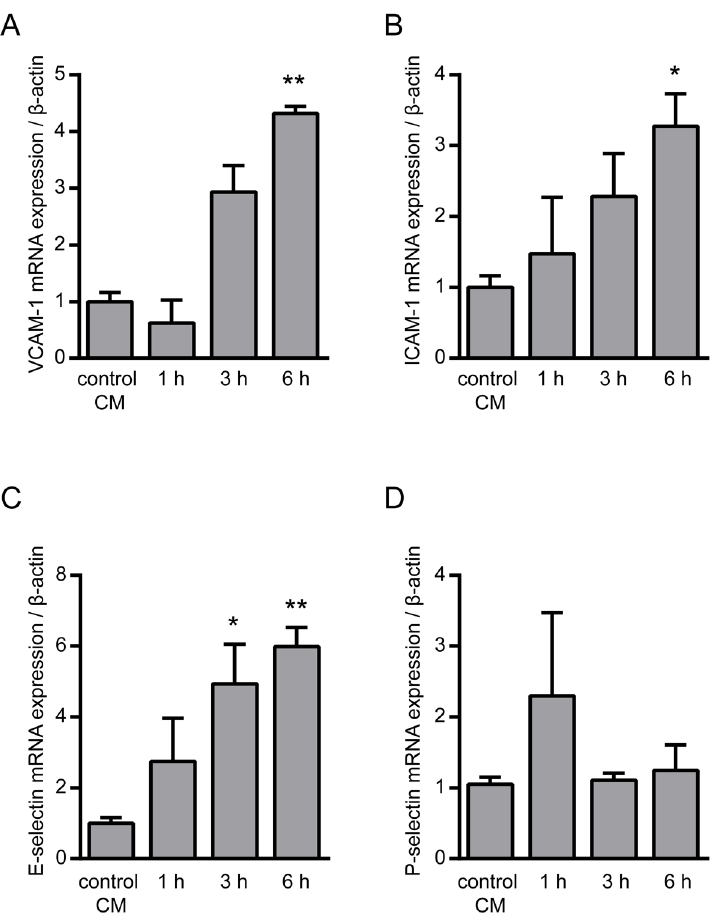
Fig 2. Effect of conditioned media from oxLDL-stimulated THP-1 macrophages on endothelial adhesion molecules. mRNA expression of the adhesion molecules (A) VCAM-1, (B) ICAM-1, (C) E-selectin and (D) P-selectin in HUVECs following stimulation with conditioned media from oxLDL stimulated THP-1 macrophages (oxLDL CM) was determined by real time PCR at the indicated time points. Conditioned medium from unstimulated THP-1 macrophages were used as control (control CM). * P < 0.05, ** P < 0.01, *** P < 0.001 vs. control CM, n = 4 – 5 replicated